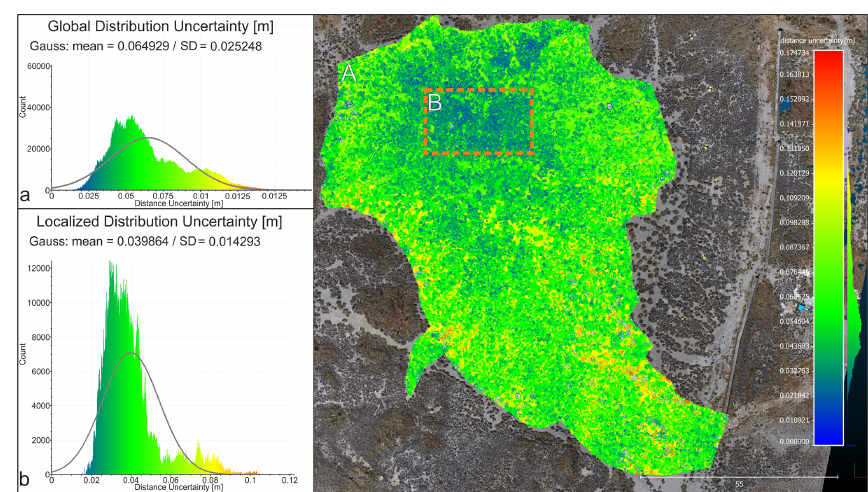
Figure 13. Point clouds with uncertainty distance values between 29 July 2019 and 15 June 2020 (right). On the left, (a) the Gaussian distribution of the distance uncertainty over the whole area is shown; the mean is about 6.4cm, and the standard deviation is about 2.5cm. (b) The Gaussian distribution of the distance uncertainty of the central emission area is shown; the mean is about 3.9cm, and the standard deviation is about 1.4cm. The reference system is WGS 84/UTM zone 33N.